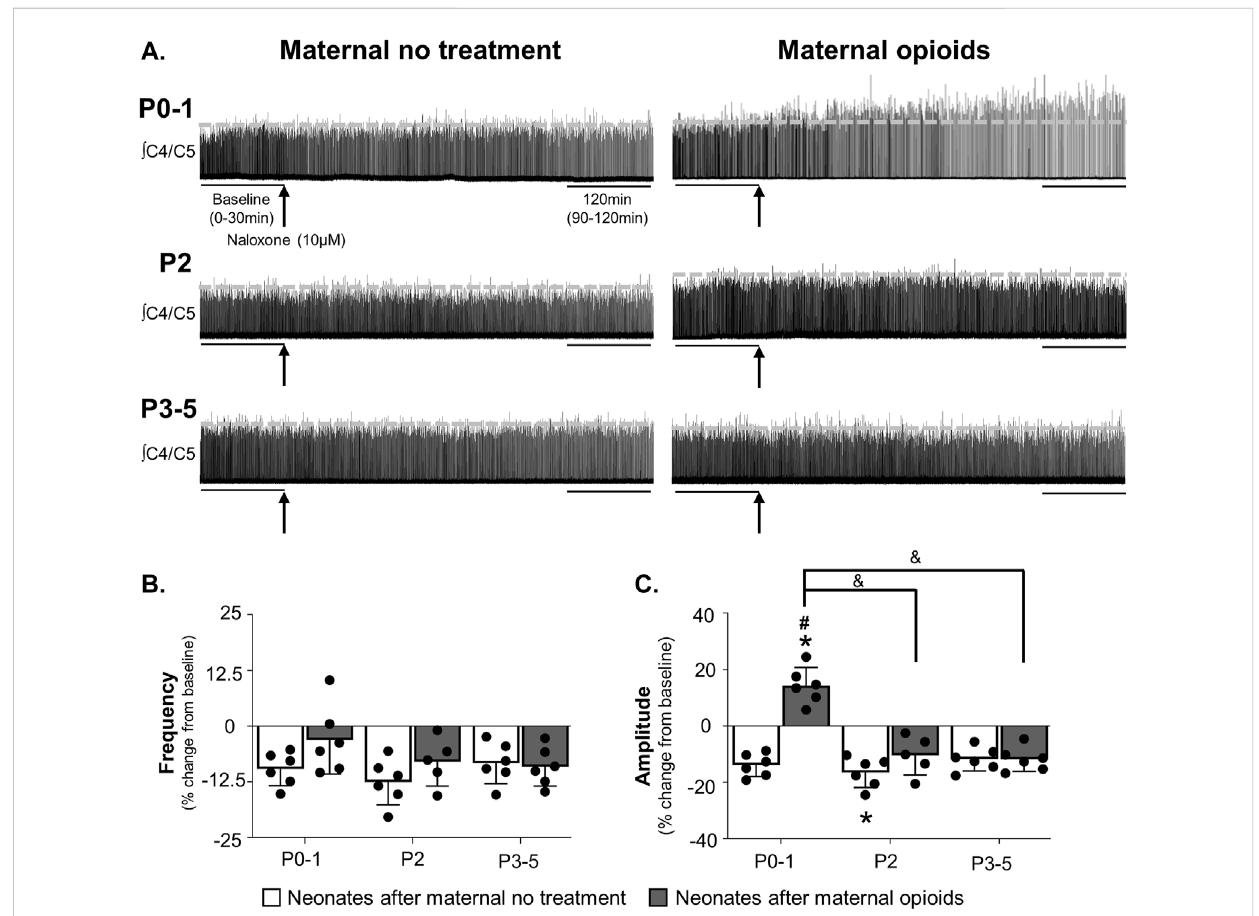
FIGURE 2 Mu-opioid receptor antagonism increased respiratory burst amplitude, but not frequency, in neonates after maternal opioids. Respiratory neurograms (A) show respiratory activity in isolated neonatal brainstem-spinal cords were unchanged after mu-opioid receptor antagonism (arrow, naloxone,10 µM,bathapplication)inneonatesaftermaternalnotreatmentatanyageandincreasedinP0-1neonatesaftermaternal opioids.Respiratory burst frequencies (B) were unchanged from baseline after mu-opioid receptor antagonism in any maternal treatment or age. Respiratory burst amplitudes (C) decreasedfrombaselineinP2neonatesaftermaternal notreatment andincreasedfrombaselineinP0-1neonatesaftermaternalopioids. Respiratory burst amplitude increased in P0-1 neonates after maternal opioids compared to all neonates after maternal no treatment (white bars) and older (P2 and P3-5) neonates after maternal opioids (gray bars) (* p < 0.05 different from baseline; # p < 0.05 different from neonates after maternal no treatment at all ages; & p < 0.05 different from neonates after maternal opioids; Three-way ANOVA; Bonferroni post-hoc